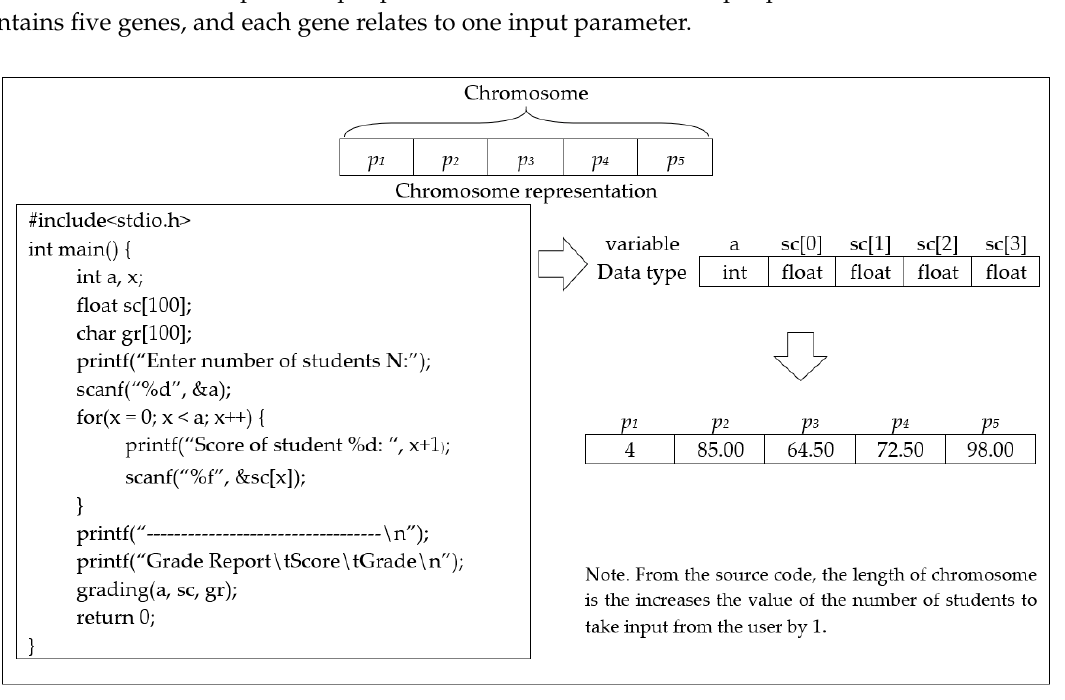
Figure 1. Chromosome representation to generate test cases using a genetic algorithm (GA). Each chromosome has five genes ( p ) that each correspond to one input parameter of a specific data type.